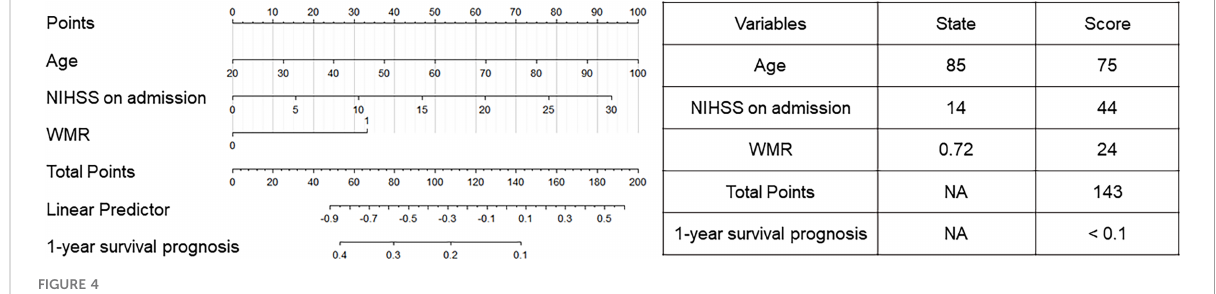
FIGURE 4 Instructions for using